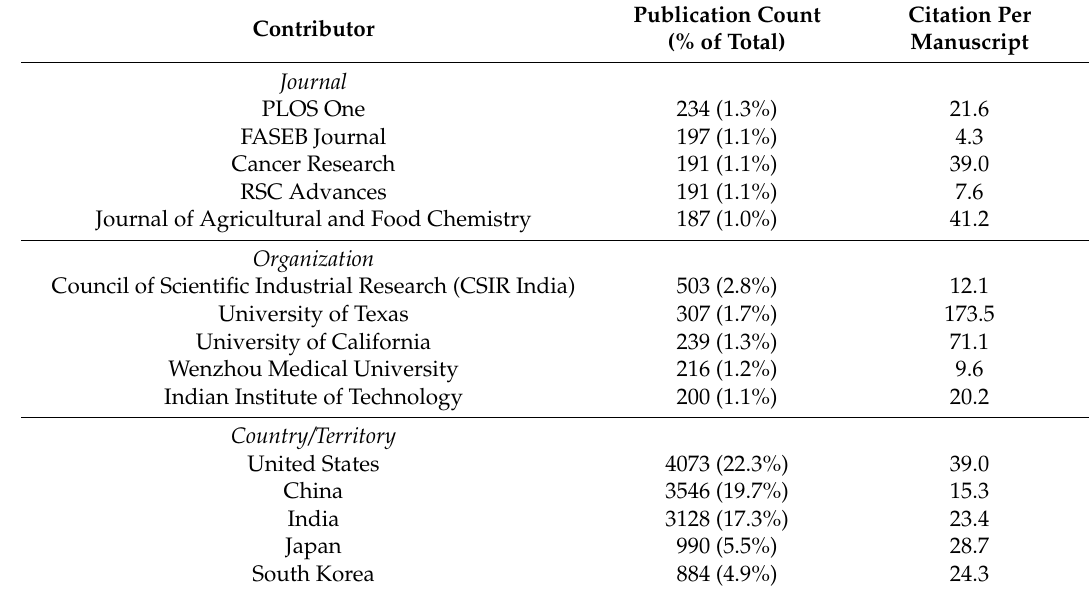
The top five contributor journals, organizations, and countries/territories of the 18,036